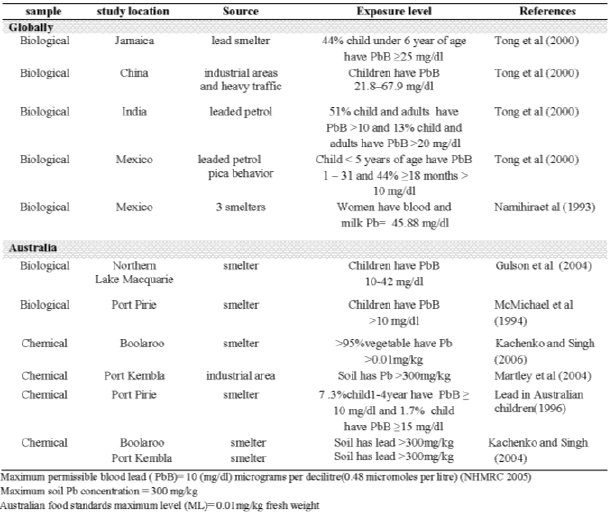
Table 1 Typical worldwide sources of Pb contamination which are of health